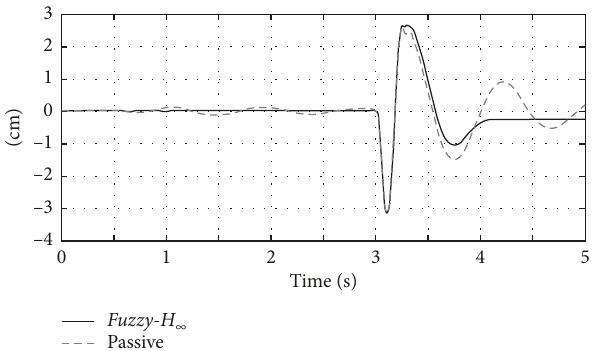
Figure 11: Rear suspension’s deflection ( Z